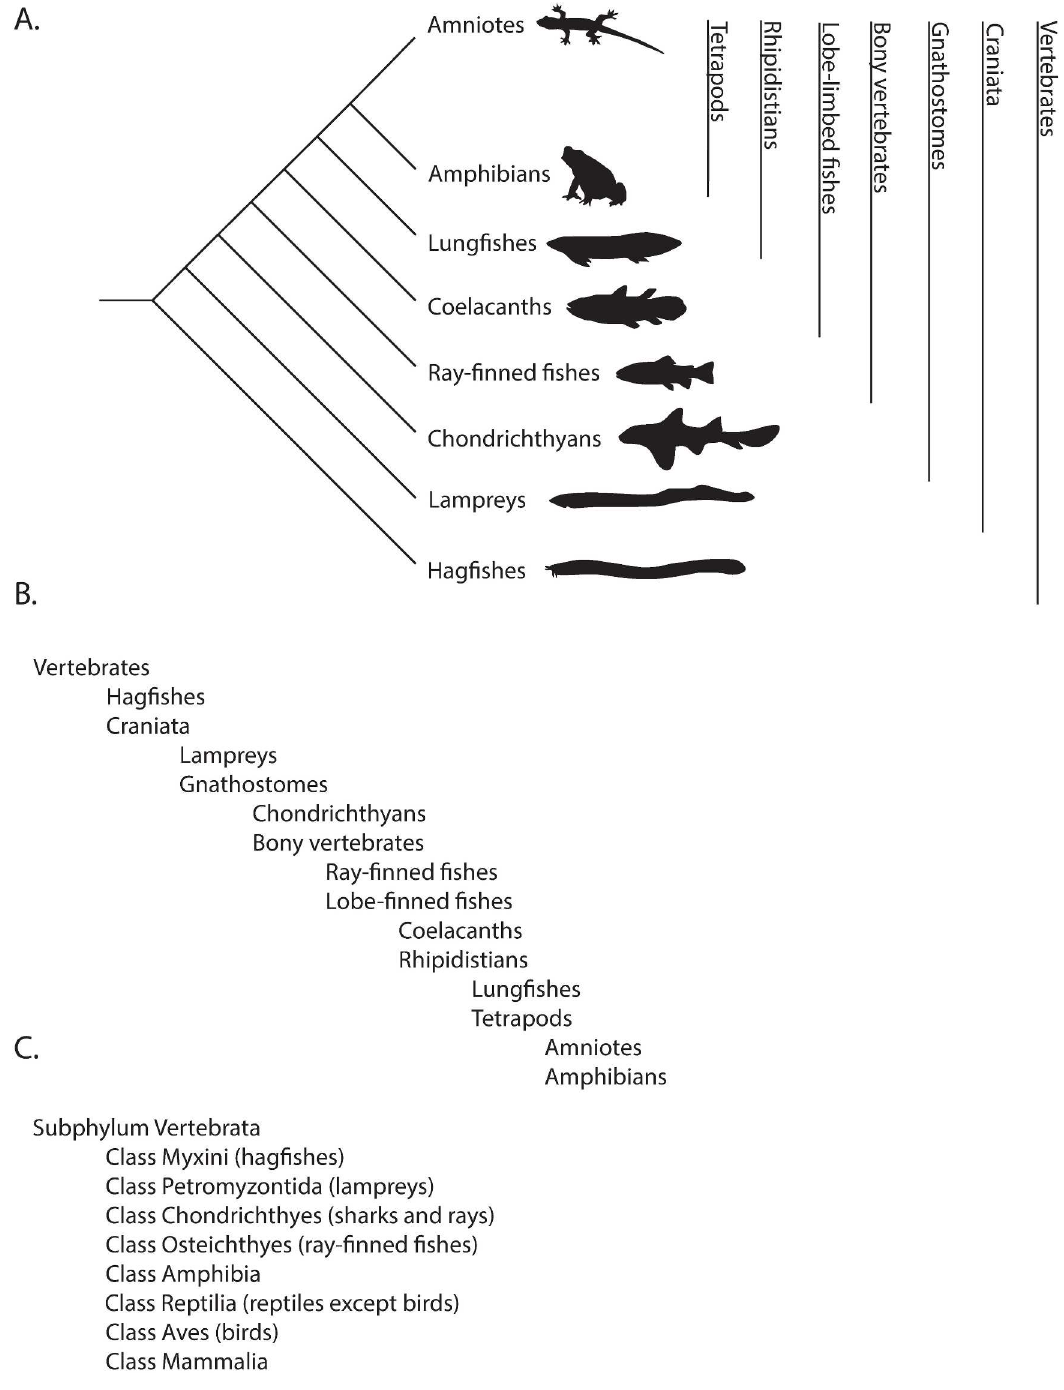
Fig 1. (A) A phylogenetic tree reflects the evolutionaryrelationships amongmajor living vertebrate taxa. The vertical bars represent monophyletic groups that encompasscorresponding taxa on tree tips. (B) The indentedclassification of major vertebrate taxa. Note how the indentedclassification correctly portrays the relationshipsdepictedby the phylogenetictree. (C) Traditional rank-basedclassification of the same living vertebrate taxa is inconsistentwith portrayals in (A) and (B). The traditional classificationobscuresrelationships amongtaxa, e.g., some Osteichthyes (coelacanths, lungfish)are more closely related to tetrapods than to other “fishes”; it also fails to denote three hugeevolutionaryinnovations in the history of vertebrates: jaws, four limbs, and the amniotic